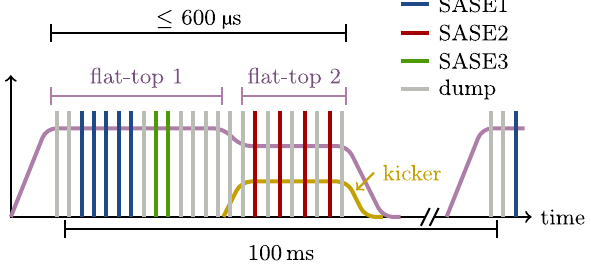
FIG. 3. Simplified diagram of the EuXFEL timing pattern. The rf accelerating pulses (purple line) have a repetition rate of 10 Hz and can be filled with bunches (bars, the color bars indicate the destination) at a maximum rate of 4.5 MHz. A slow kicker- septum system (brown line) is used to distribute bunches to the SASE2 undulators (see Fig. 2) for which the rf (flat-top 2) can be individually optimized.